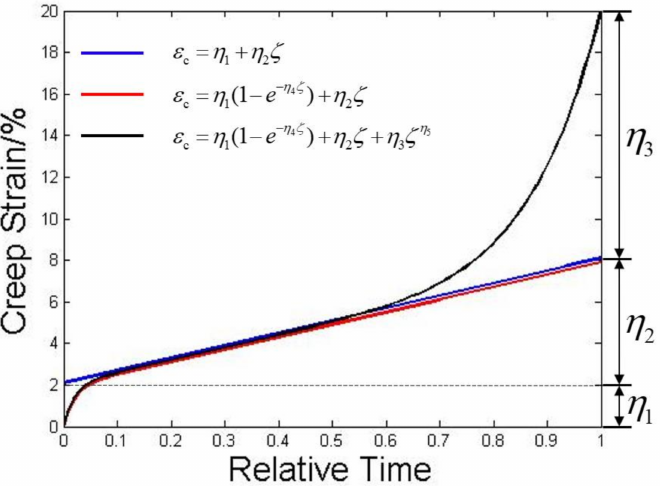
Figure 2. Creep equation schematic diagram. Table 5. Creep curve parameter fitting results.